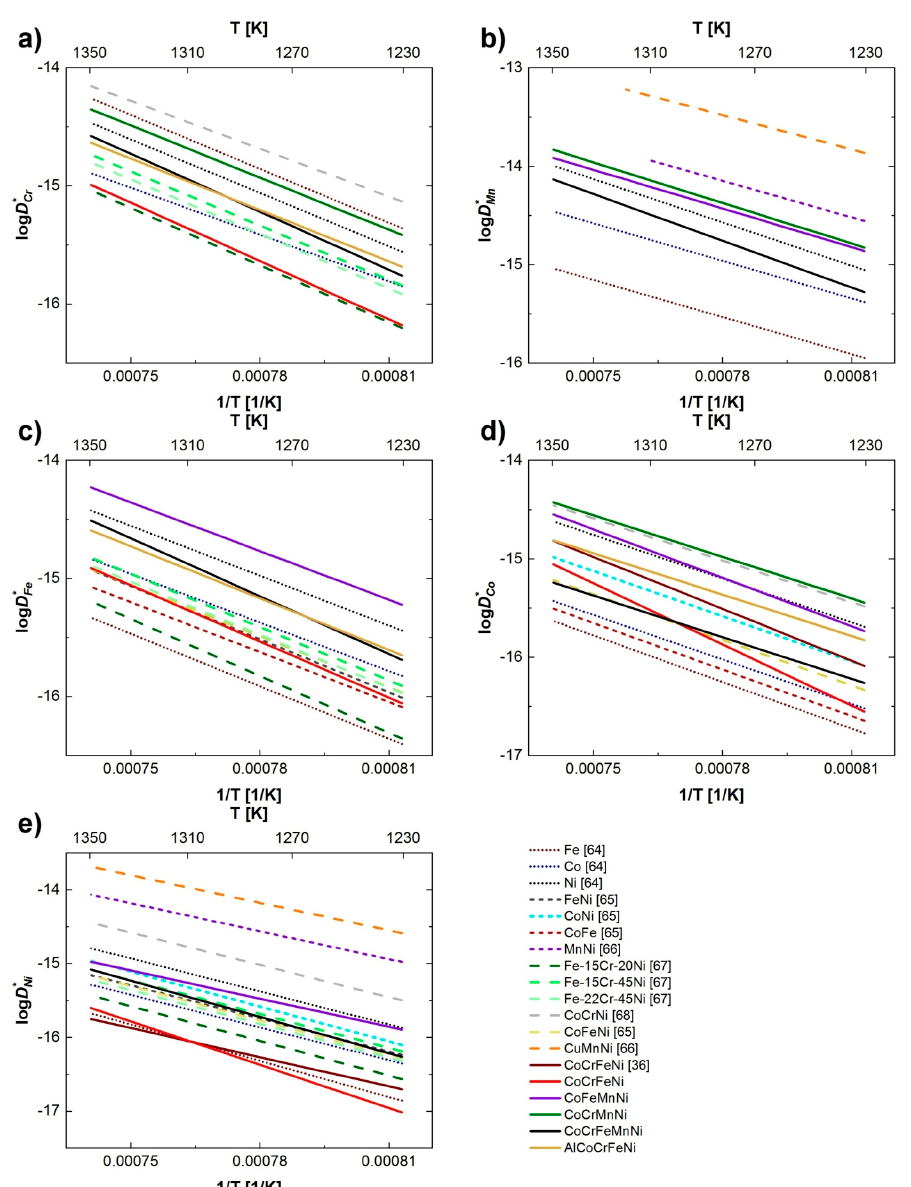
Figure 27. Tracer diffusion coefficients of different elements in different FCC matrices: ( a ) Cr, ( b ) Mn, ( c ) Fe, ( d ) Co, ( e ) Ni. All plots are presented on an absolute temperature scale [45]. Reprinted from Journal of Alloys and Compounds 783 (2019), Demystifying the sluggish diffusion effect in high entropy alloys, 193–207, Copyright 2019, with permission from Elsevier.